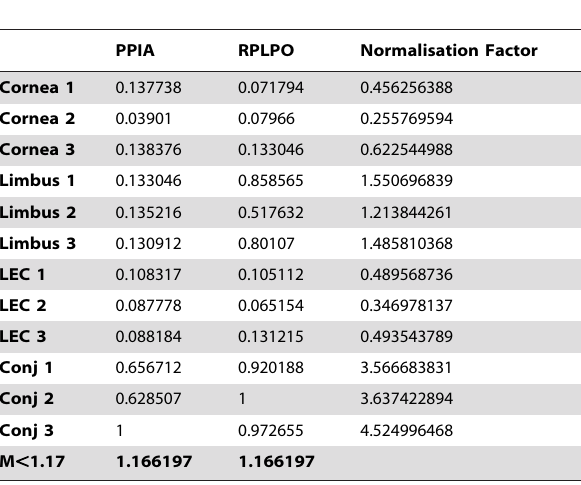
Table 3. Normalisation factor calculated with stable pair of endogenous control genes.